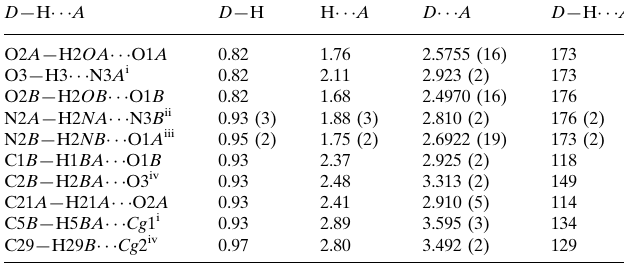
Hydrogen-bond geometry (A˚ , (cid:2)